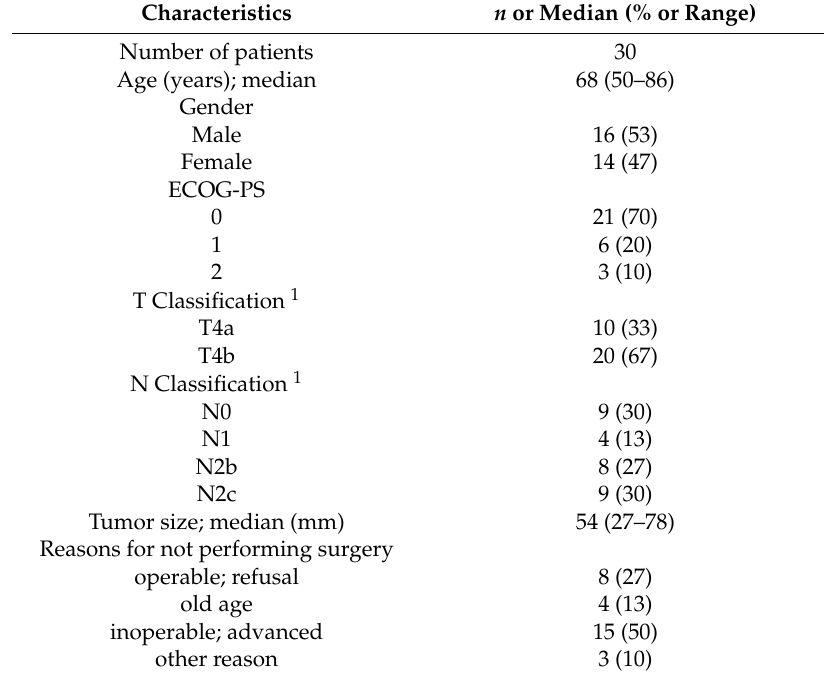
Table 1. Patient and treatment